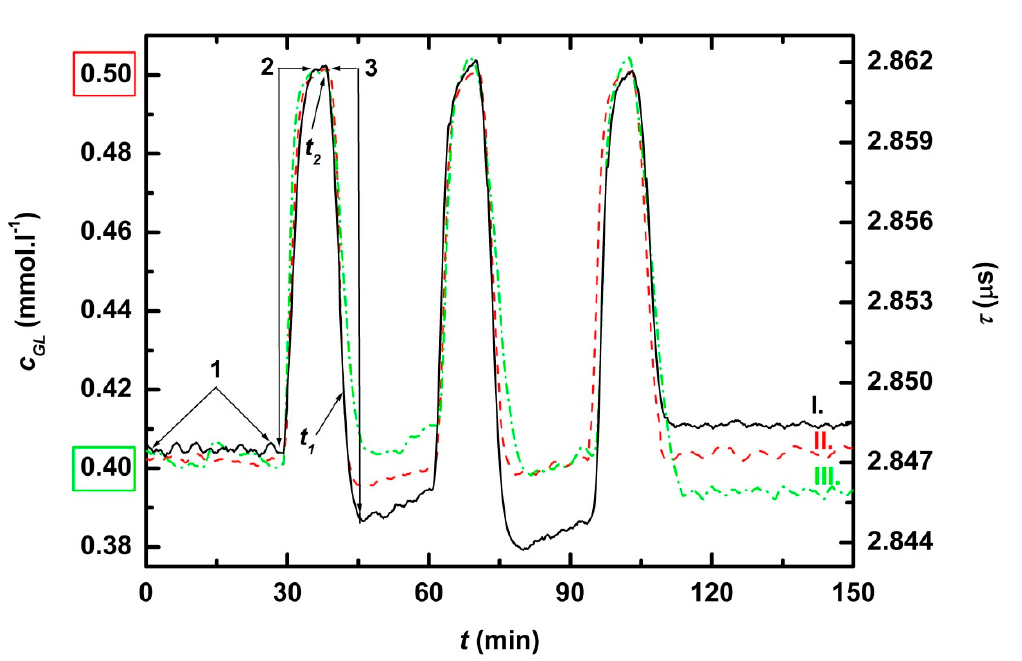
Figure 3. Time record of the feedback regulation of lower glucose concentration (dilution with buffer) for three independent experiments at the same conditions (I.-III.). After the initial three t chec (position 1), the concentration of glucose was increased from c GLDES = 0.4 mM to c GLMAX = 0.5 mM by hand pipetting of concentrated glucose solution into the bioreactor (position 2). After c GLMAX detection, the pump of feedback loop dosed buffer into the reactor (position 3). t 1 is time when actual measured glucose concentration exceeded glucose concentration after regulation for 10% and t 2 is time when buffer was added.